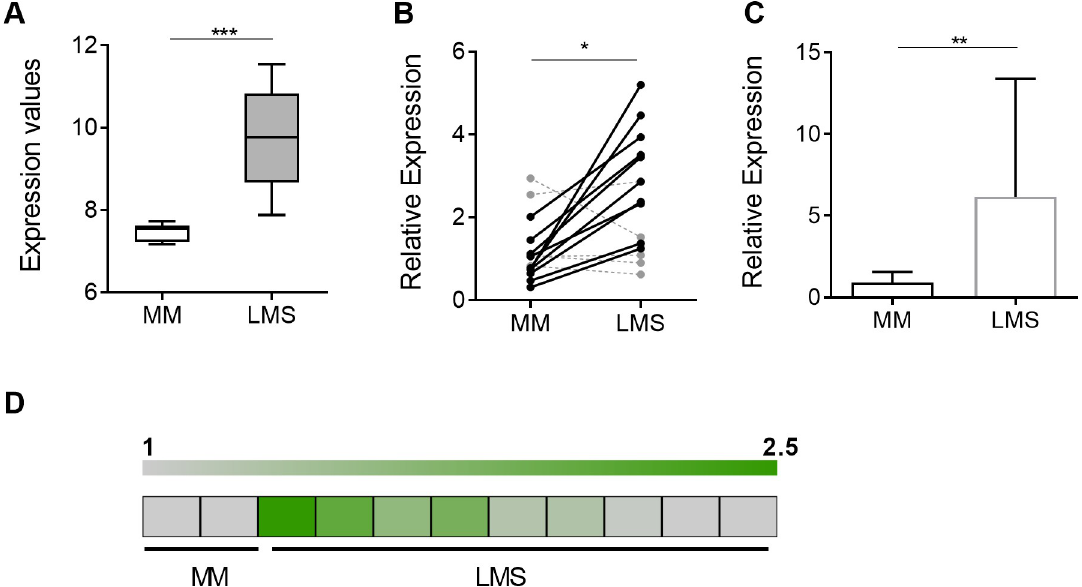
Fig 1. MiRNA-130b expression is upregulated in LMS. (A) Relative miR-130b levels, determined by miRNA array profiling of myometrial (MM; n = 10) and leiomyosarcoma (LMS; n = 10) tissues adapted from previously published data [14]. (B) Relative miR- 130b levels, measured by RT-qPCR, in separate cohort of matched MM and LMS tissues (n = 15). Expression values are normalized to the average miR-130b expression levels for the whole MM group. (C) Relative miR-130b levels, measured by RT-qPCR, in a third cohort of non-matched MM (n = 19) and LMS (n = 13) tissues. (D) Gene amplification, determined by qPCR, of the MiR-130b locus in MM (n = 2) and LMS (n = 9) tissue samples, represented as a heat map. Average levels in normal MM (= 1) are indicated by grey color; amplified loci are represented by shades of green. Statistical analyses were performed by two-tailed students t-test; � P < 0.05, �� P < 0.005, ��� P <